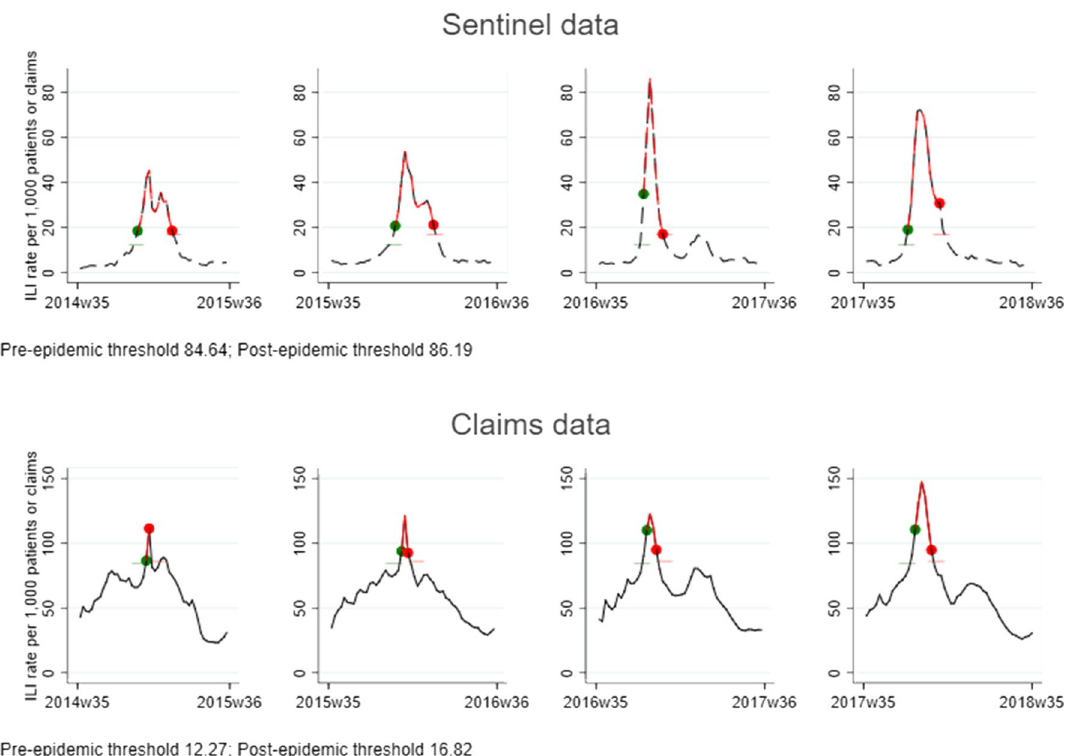
Figure 5. Epidemic thresholds for the surveillance of ILI rates from the KCDC sentinel data and National Health Insurance claims